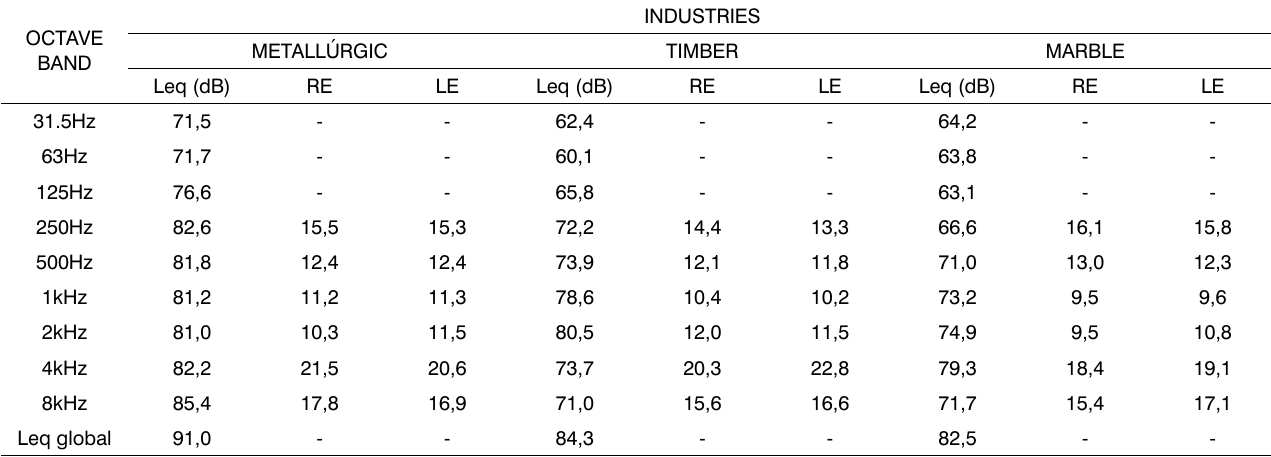
L eq Sound pressure equivalent level; RE right ear; LE left ear.